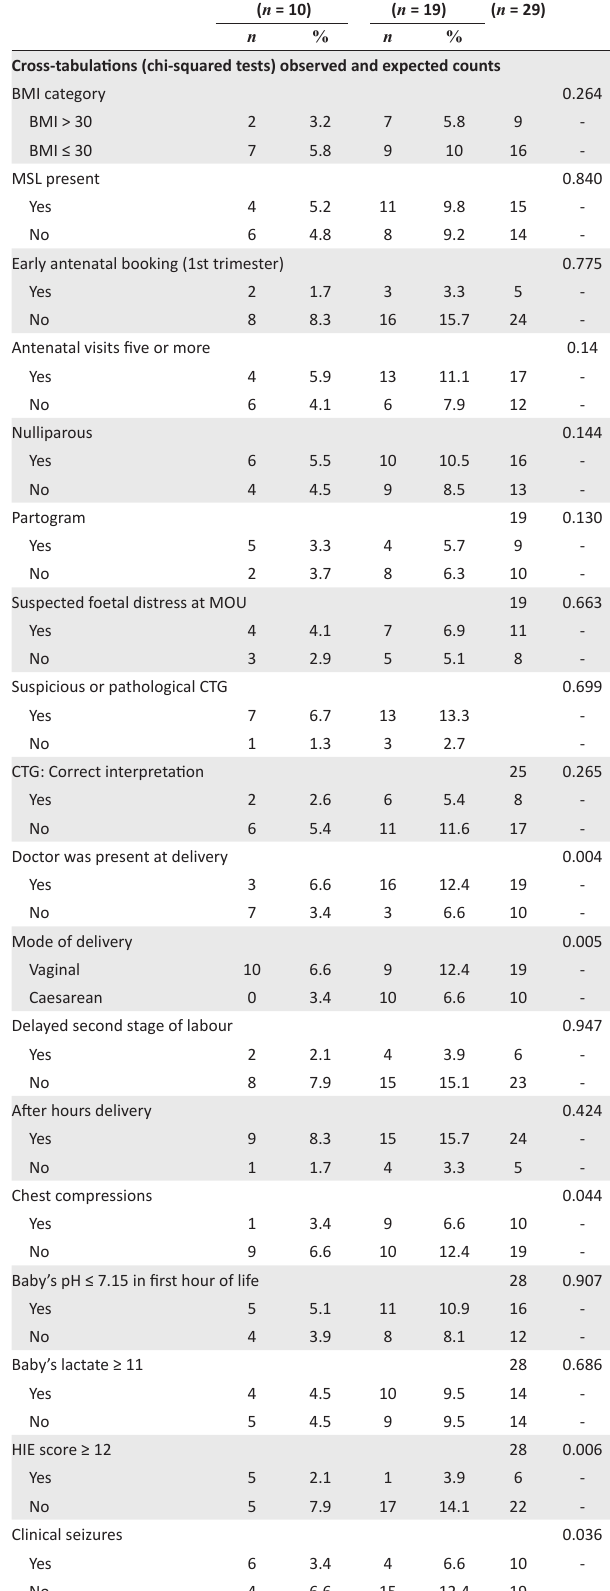
TABLE 5a: Associations between variables and outcomes (abnormal amplitude electroencephalograms and mortality) represented by cross-tabulations and chi-square tests. Variable Abnormal aEEG ( n =